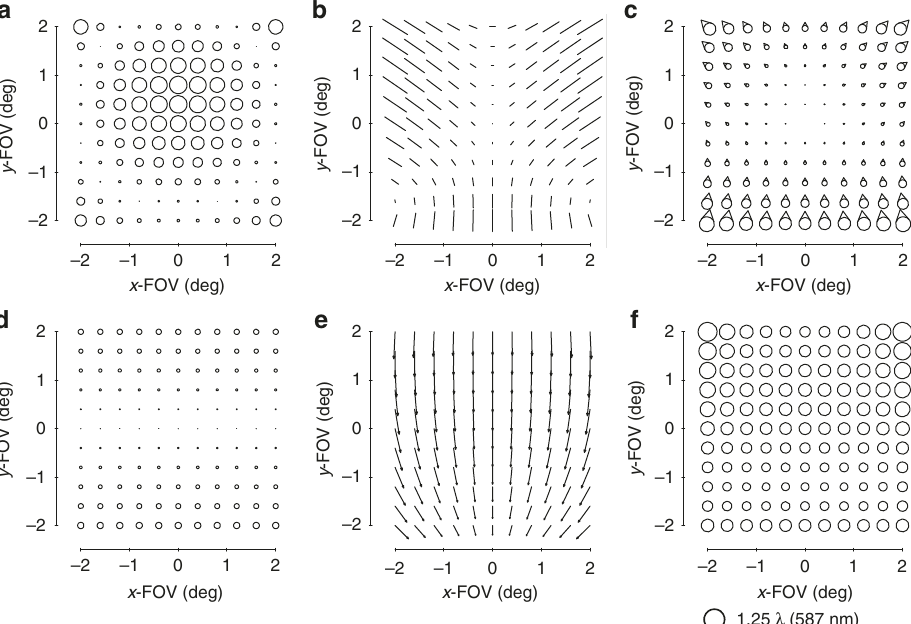
Fig. 5 Zernike-based aberration FFDs after conics. After adding conics to all three mirrors and allowing the radii, tilts, and airspaces to vary, the aberrations of the system were calculated and are shown in FFDs for a defocus (Z4), b astigmatism (Z5/6), c coma (Z7/8), d spherical aberration (Z9), e elliptical coma (Z10/11), and f RMS WFE. Note the scale decreased 10× from Fig. 4